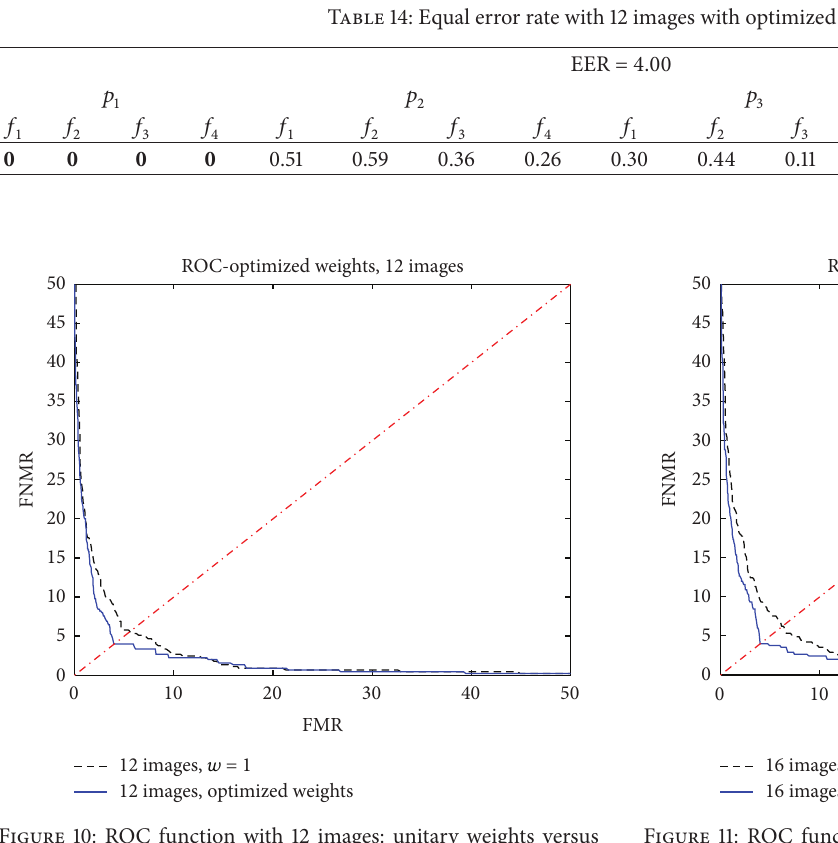
Figure 10: ROC function with 12 images: unitary weights versus optimized weights.